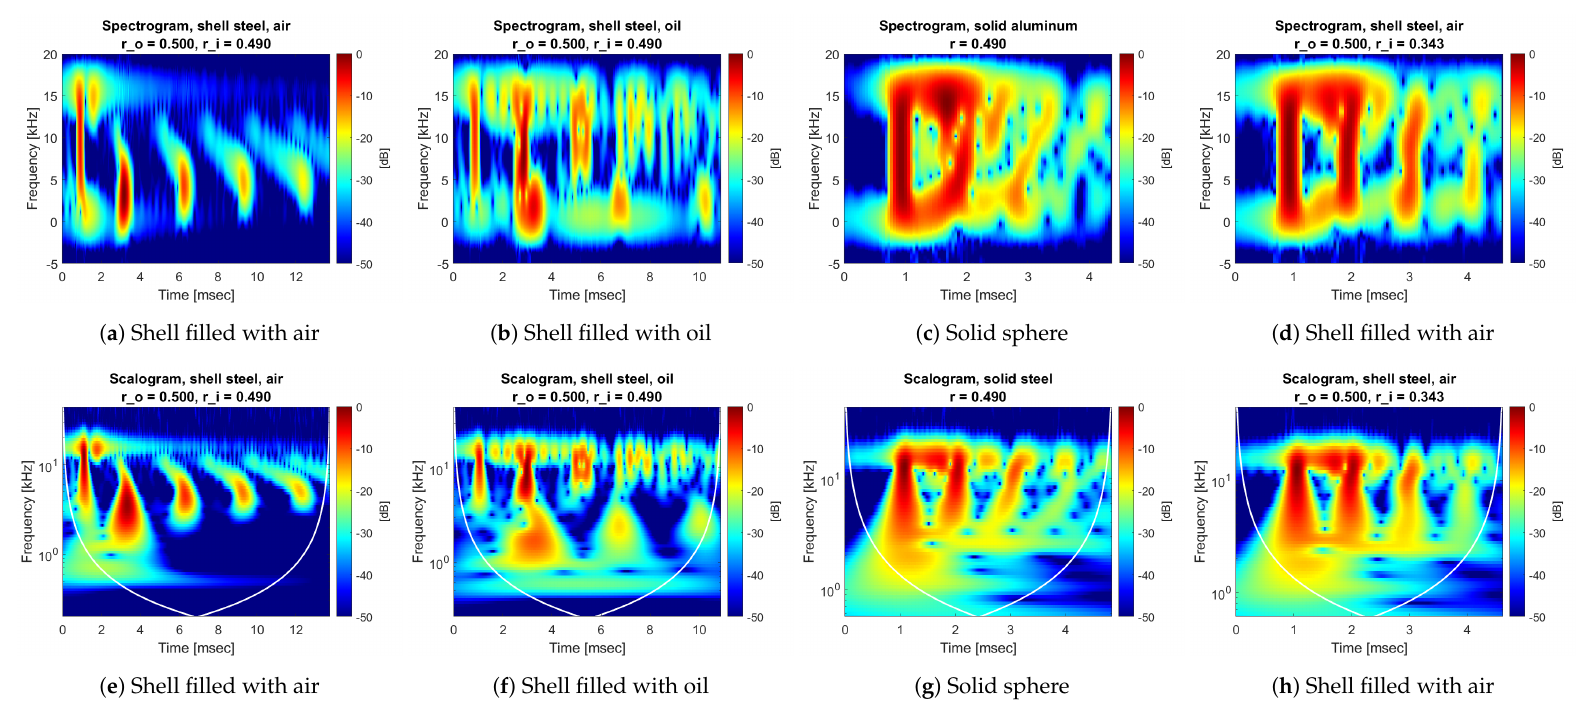
Figure 3. Spectrograms ( a – d ) and scalograms ( e – h ) of the segmented backscattered responses generated from stainless steel 347 with a 20 dB SNR. The white lines on the scalograms represent the cone of influence. Spectra are depicted for a shell filled with air (( a ) spectrogram and ( e ) scalogram), a shell filled with oil (( b ) spectrogram and ( f ) scalogram), and a solid sphere with a radius of 0.49 m (( c ) spectrogram and ( g ) scalogram). All shells had an outside radius of 0.50 m and inside radius of 0.49 m. The inset ( d ) depicts the spectrogram, and the other inset ( h ) depicts the scalogram of a shell filled with air with an inside radius of 0.343 m. Notice how the resonances vary depending on the geometry (shell vs. solid) and inside fluid used for the simulation (air vs. octane oil). The resonances also morph as a function of the target size, as can be seen when comparing insets ( a – d ) and ( e – h ). The unit is decibels and in reference to the highest pixel